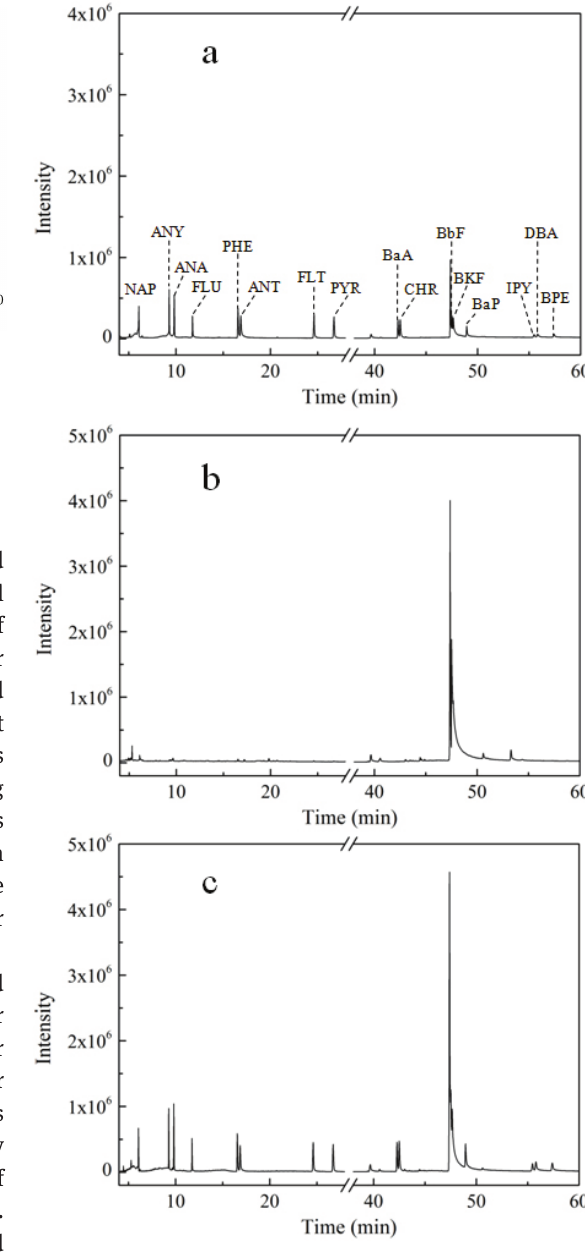
Figure 6: GC-MS chromatograms under SIM mode of PAHs in (a) PAHs standard solution, (b) blank water sample and (c) spiked water